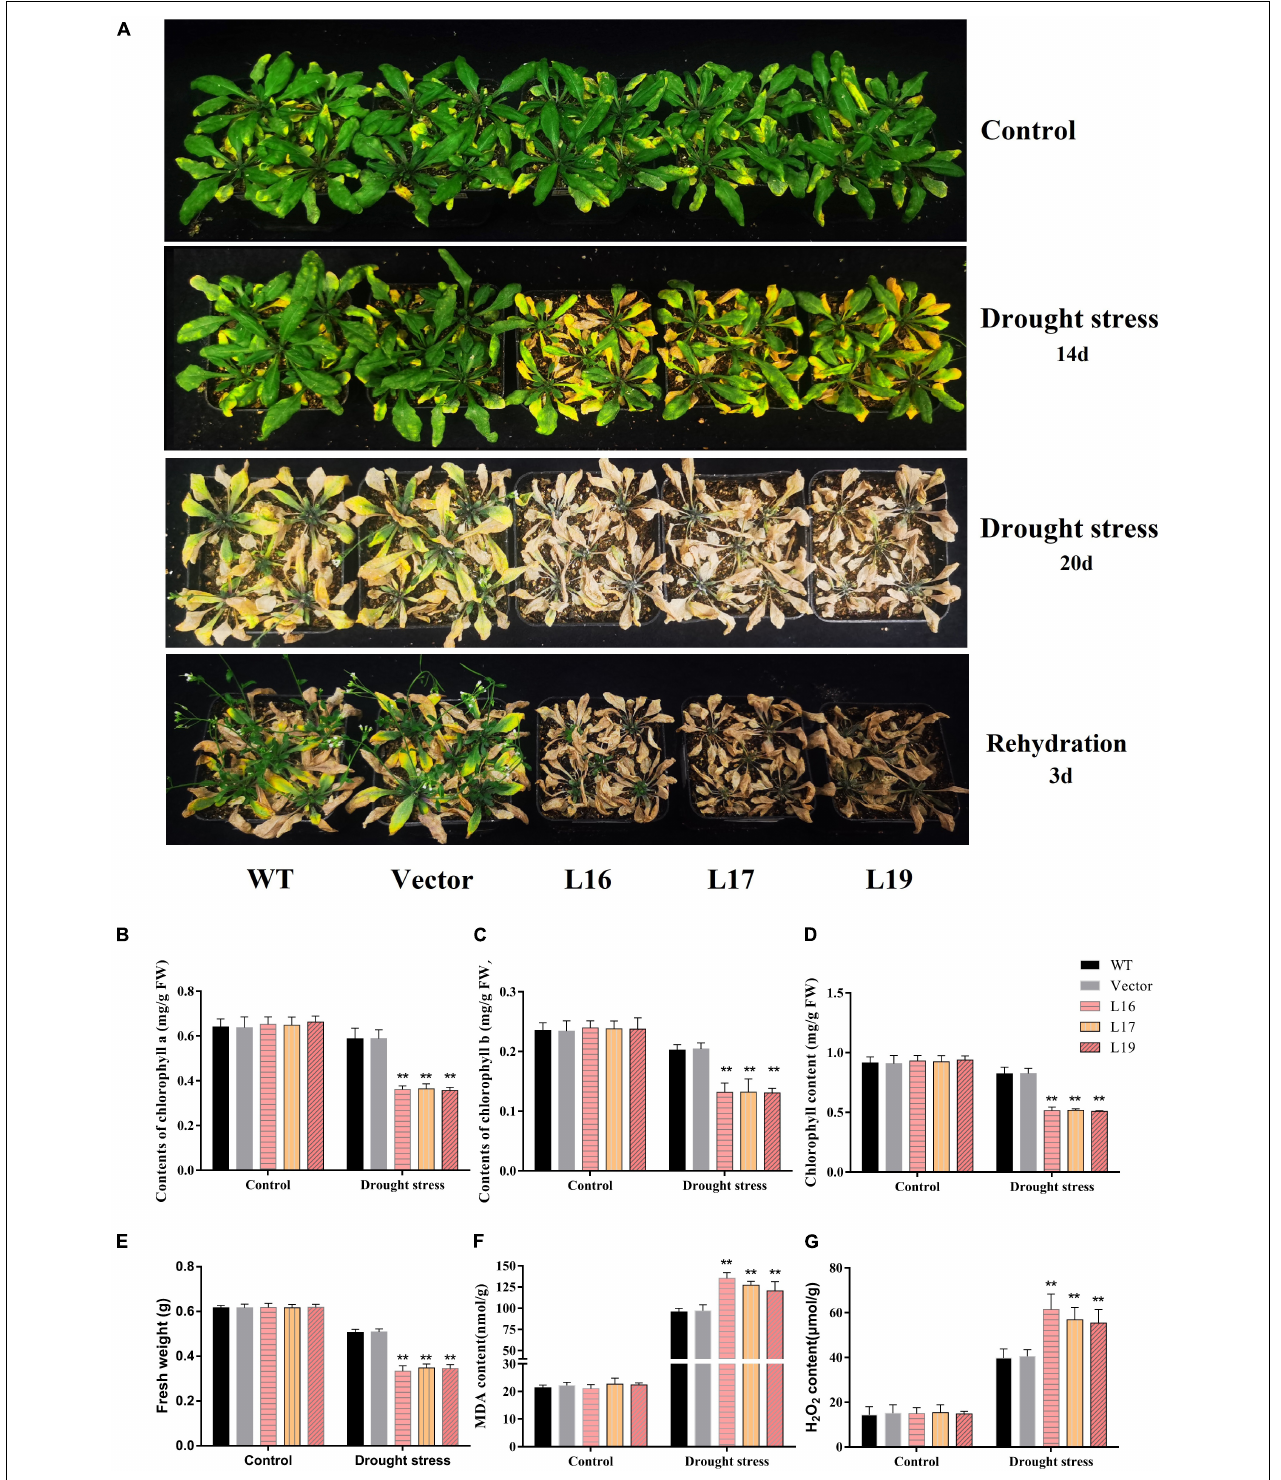
FIGURE 4 | Phenotype and physiological index of transgenic Arabidopsis under drought stress. (A) Phenotype of control (wild type and vector) and GmFBL144 -overexpression lines (L16, L17, and L19) under drought stress. (B–G) Physiological index of control and GmFBL144 -overexpression plants under drought stress, including chlorophyll content (B–D) , fresh weight (E) , MDA content (F) , H 2 O 2 content (G) . Data represent means ± SE of three biological replicates. Asterisks indicate significant difference applying ANOVA (* P < 0.05; ** P < 0.01; *** P < 0.001).